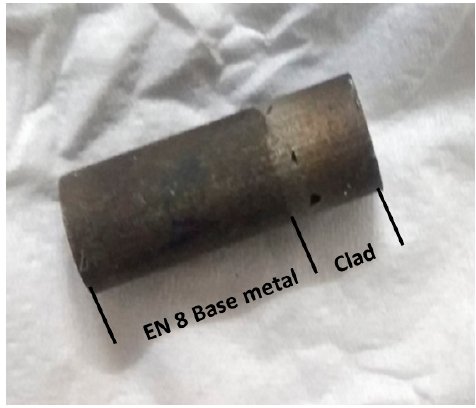
Figure 2. Pin used in pin on disc for wear test.